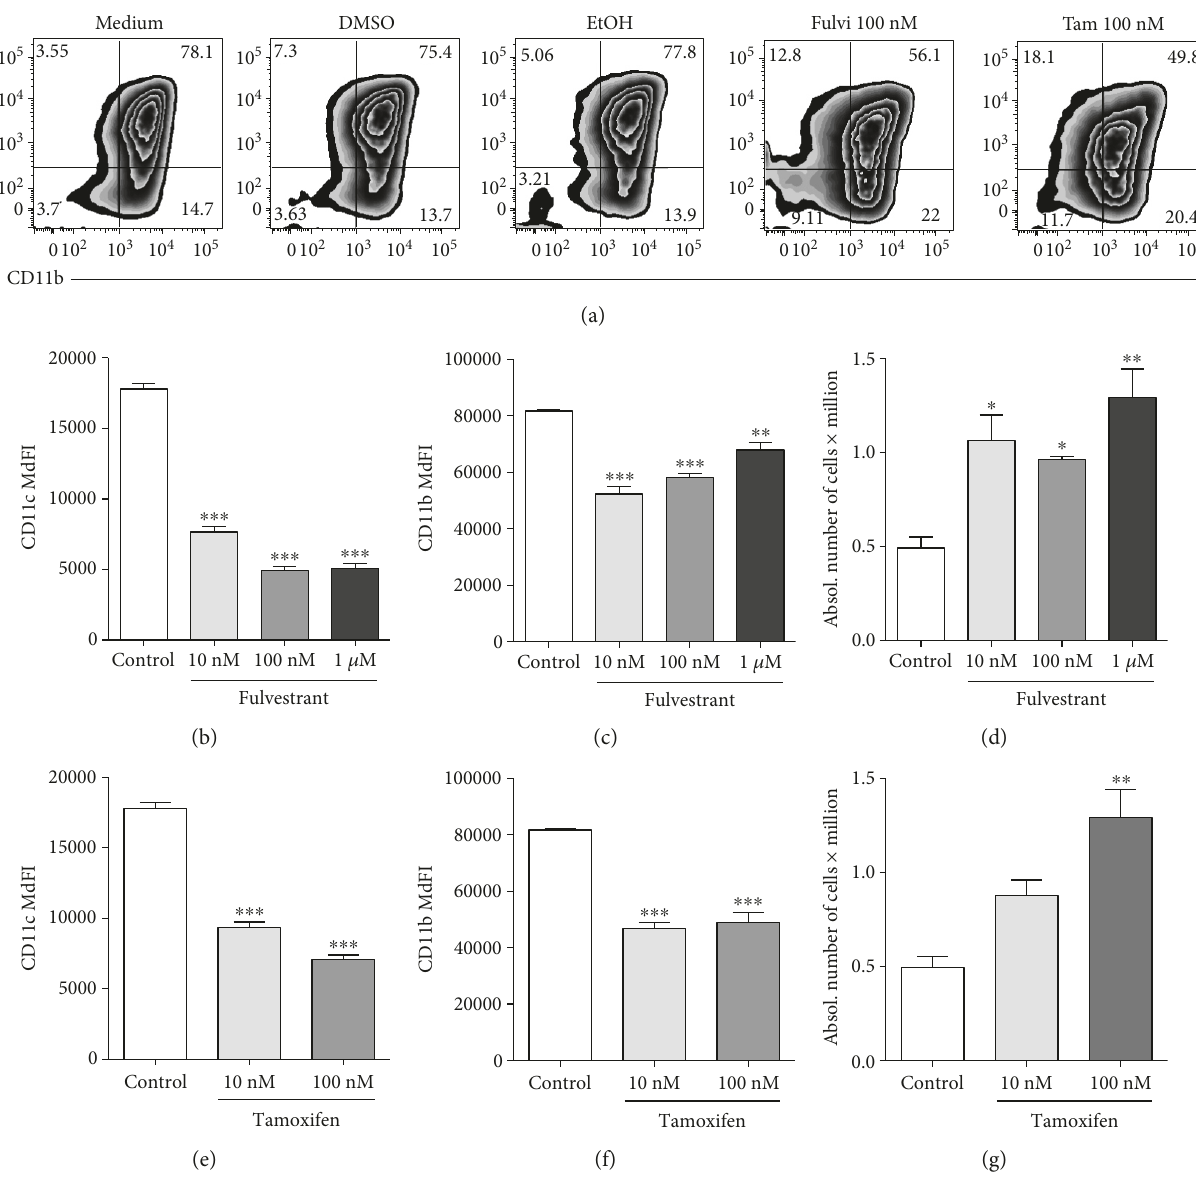
Figure 2: SERMs decrease the in vitro di ff erentiation of dendritic cells. Days 6-7 of the culture of cDCs grown in the regular medium and in the absence or presence of fulvestrant or tamoxifen. (a) Representative plot of the fl ow cytometry analysis of CD11c and CD11b expression in the alive gate of cDCs generated in standard medium supplemented with 100 nM fulvestrant or 100nM tamoxifen. (b – g) MdFI of CD11c (b, e); CD11b (c, f); manual counts of alive cells (d, g). Results are averages and SE of biological triplicates conducted with one independent cDC culture. Statistical signi fi cance was calculated by one-way ANOVA and post hoc multiple comparison test against the 0 condition (no E2 nor BPA) in a-0063 and against control in (d – i). ∗ represents p < 0 05 , ∗∗ for p < 0 01 , ∗∗∗ for p < 0 001